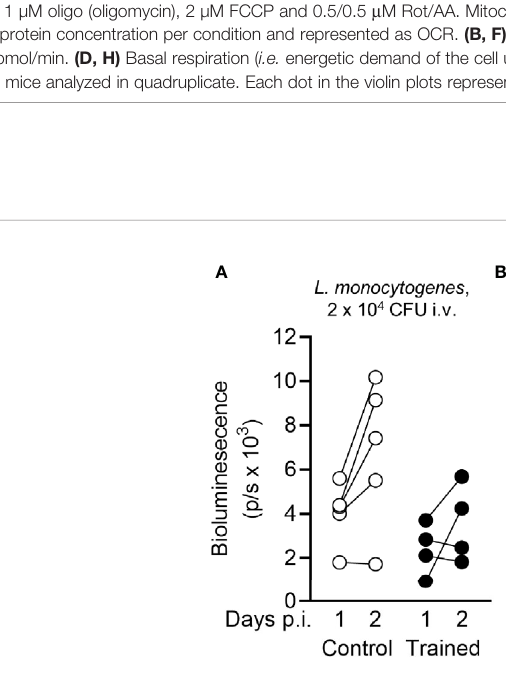
FIGURE 6 | Training for 9 weeks reduces Listeria -induced in fl ammation measured by bioluminescence imaging. Control mice and mice trained 9 weeks before infection ( n = 4 mice per group) were challenged i.v. with 1.7 x 10 4 CFU L. monocytogenes . One day and 2 days post infection, in fl ammatory levels were measured by luminol-generated bioluminescence using an imaging system. (A) Quanti fi cation of bioluminescent signals. Each dot represents a mouse. Lines connect results obtained from one animal analyzed 1 and 2 days post infection (p.i.). (B) Representative images of control and trained mice analyzed 2 days p.i. displayed as an overlay of luminescent and X Ray modalities. Control versus trained at day 1 and day 2: P = 0.052 and 0.062,